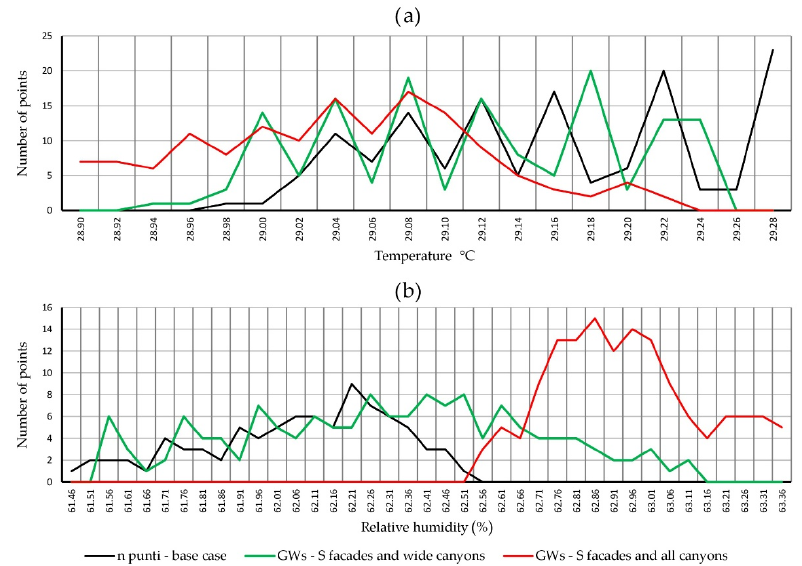
Figure 12. Distribution of the number of points in the modelled urban canyon number 1 (Figure 8) related to both the external air temperature ( a ) and the relative humidity ( b ), considering the base case, GW.1 and GW.2.